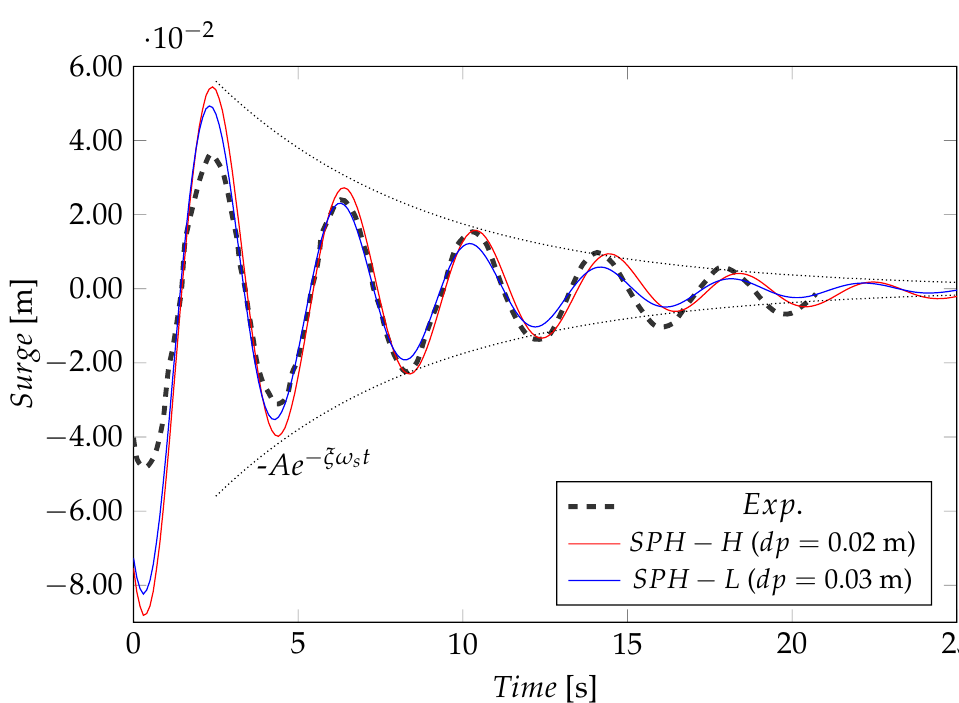
Figure 4. Perspective visualization of the numerical model during the decay test: the fluid is indicated by the colored particles whereas the geometry of the TLP is reported as a solid shape.